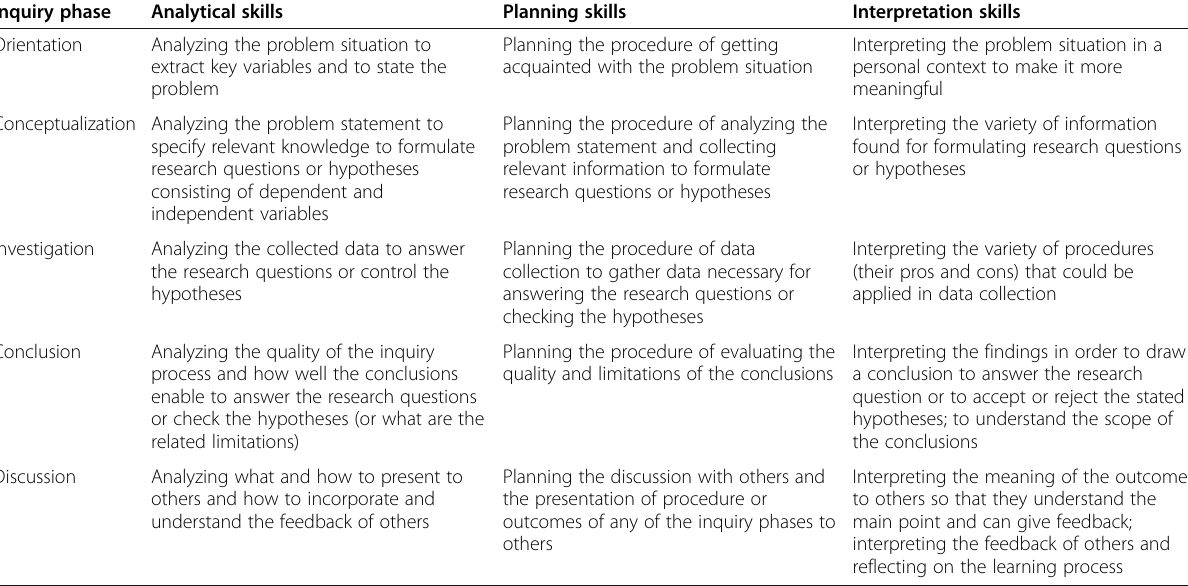
Table 1 Association of inquiry-based learning outcomes and inquiry skills Inquiry